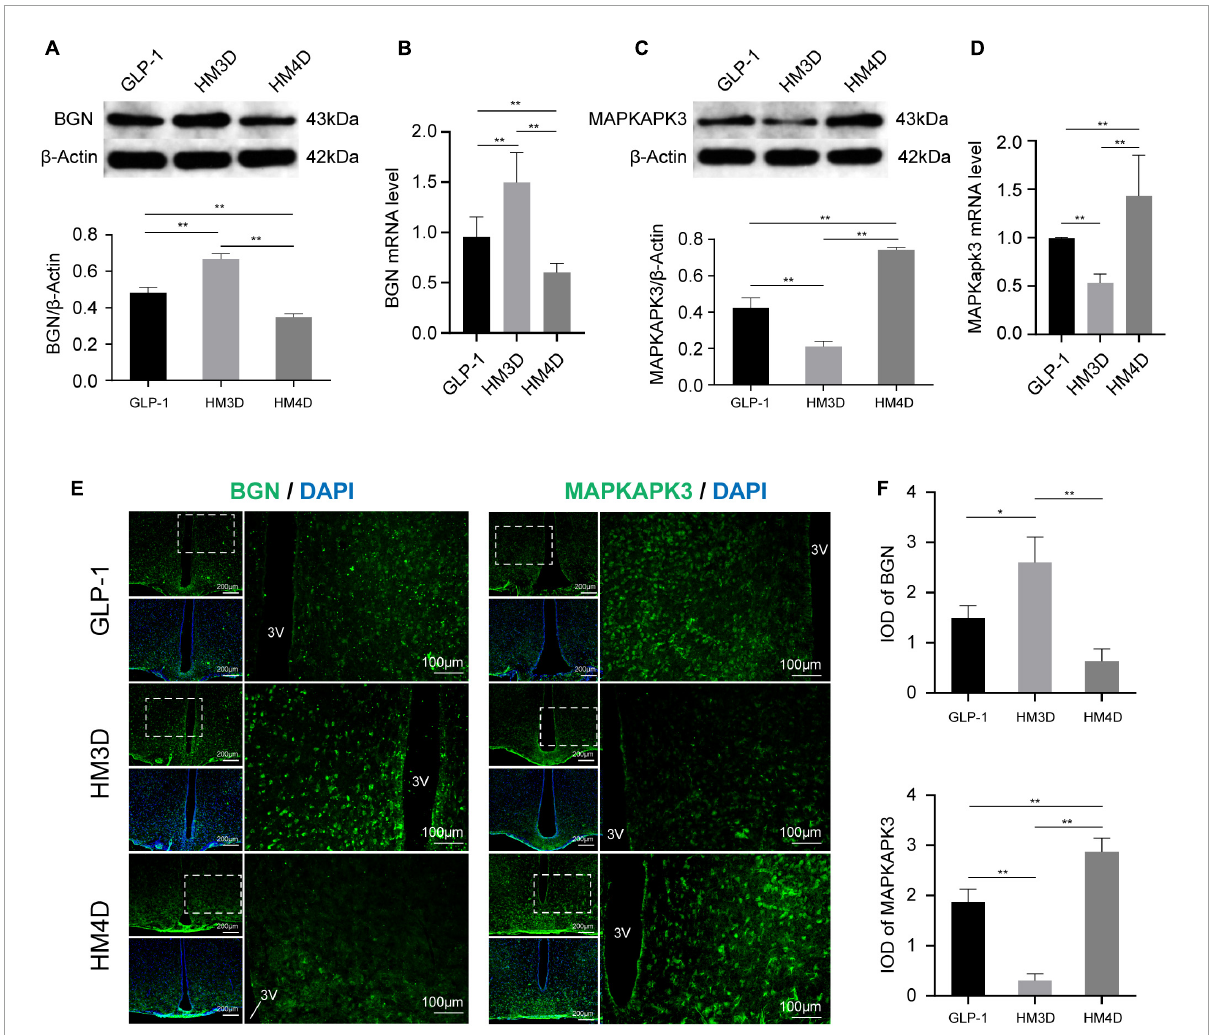
FIGURE7 Comparison of protein and gene expression of Bgn and Mapkapk3 in the hypothalamus. (A) WB and protein expression of Bgn in hypothalamus; (B) gene expression of Bgn in hypothalamus; (C) WB and protein expression of Mapkapk3 in hypothalamus; (D) gene expression of Mapkapk3 in hypothalamus; (E) representative figures of Bgn and Mapkapk3 in hypothalamus of rats in each group; (F) comparison of IOD of Bgn and Mapkapk3 in hypothalamus; * P < 0.05, ** P < 0.01. 3V, the 3rd ventricle. WB, Western blotting; Bgn, biglycan; Mapkapk3, mitogen-activated protein kinase activated protein kinase 3; IOD, integrated optical